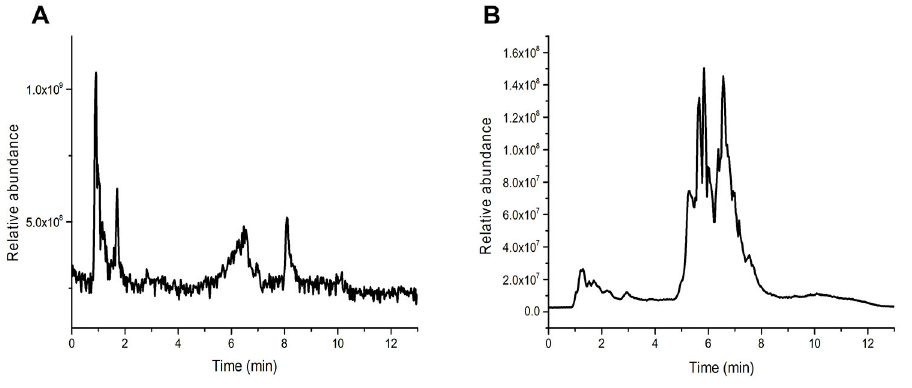
Figure 1. Total ion current diagram of SCH. Scanning range: 50–500 m / z ( A ) and 500–2000 m / z ( B ). Table 1. Contents of amino acids in SCH.